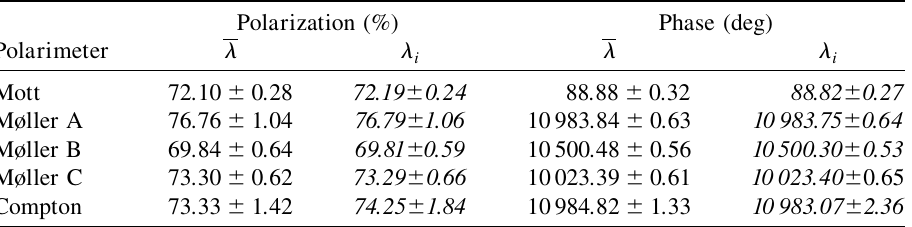
TABLE IV. Polarization and phase results for polarimeter data using (cid:12) (cid:5) 5 : 630 (cid:3) = kV ; italicized text show the values obtained using the individual (cid:12) total standard error in the fit parameters using the least squares fitting